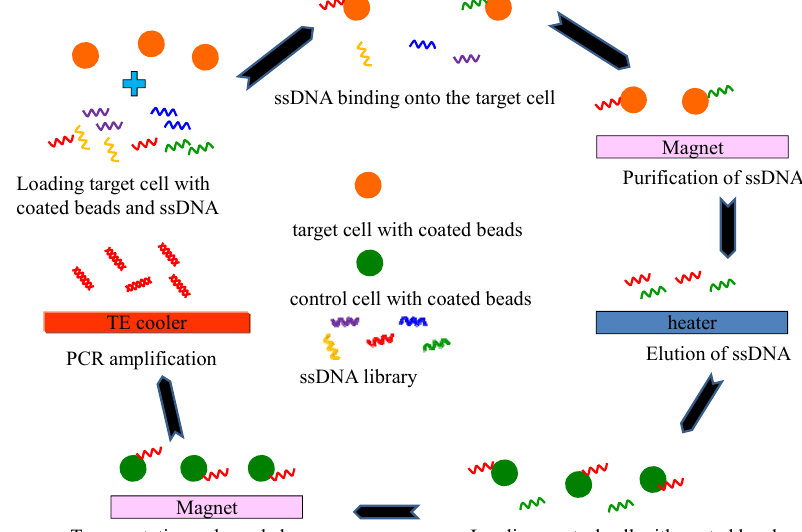
Figure 5. Schematic illustration of the Cell-SELEX processes in magnetic-bead-based microfluidic chips. Aptamers were bound to the target cells, and control cells were used for negative counter-selection. After 15–20 cycles of positive/negative selection, the highly-specific aptamer for the target cells can be